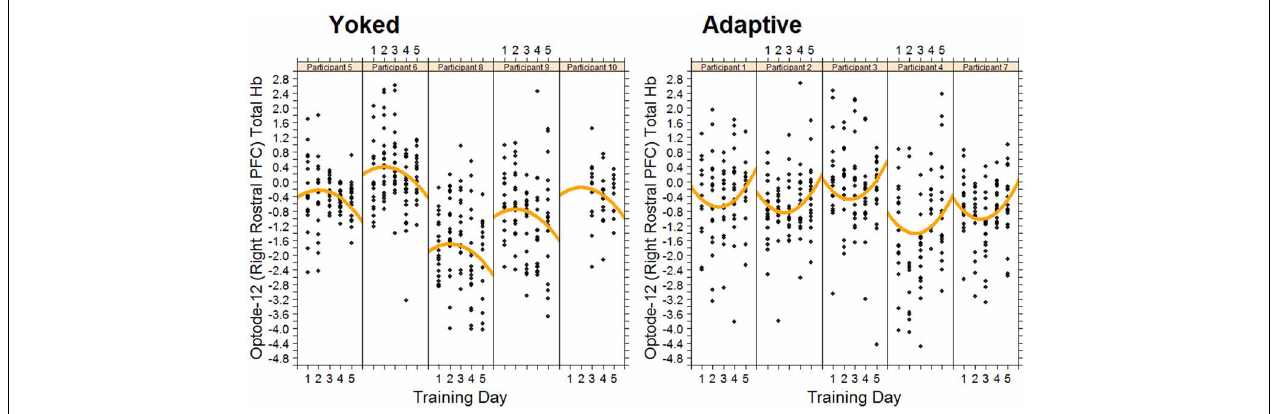
FIGURE 5 | Changes in total hemoglobin in right rostral PFC for each trainee in the adaptive training and yoked groups over 5 successive days of working memory training. Each data point represents fNIRS measured brain activity during a